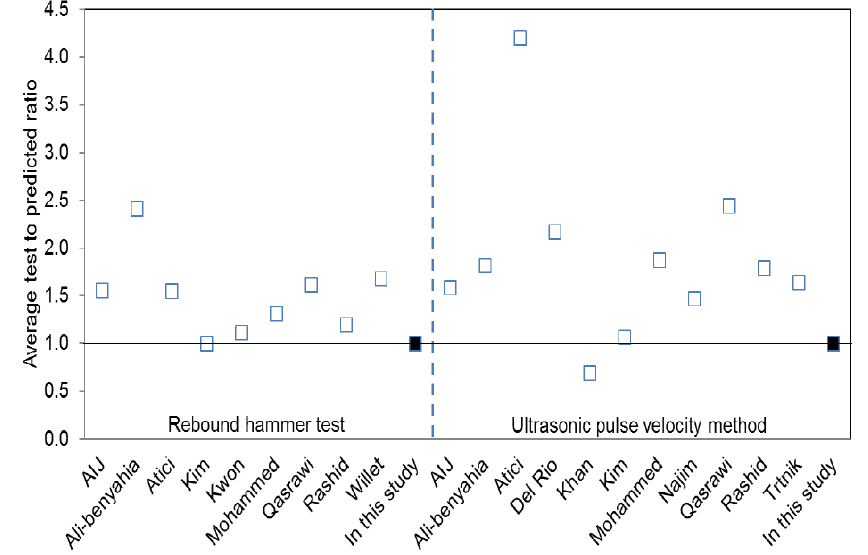
Figure 5. Ratio of the measured strength to the estimated strength.